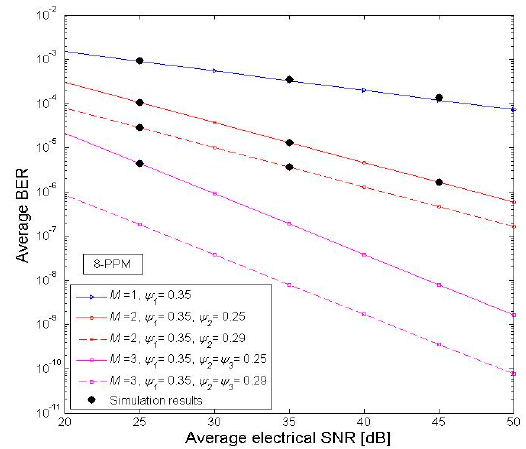
Figure 4. ABER versus electrical SNR for SISO and SIMO TOW system configurations with 8-PPM and various NZB pointing errors conditions.